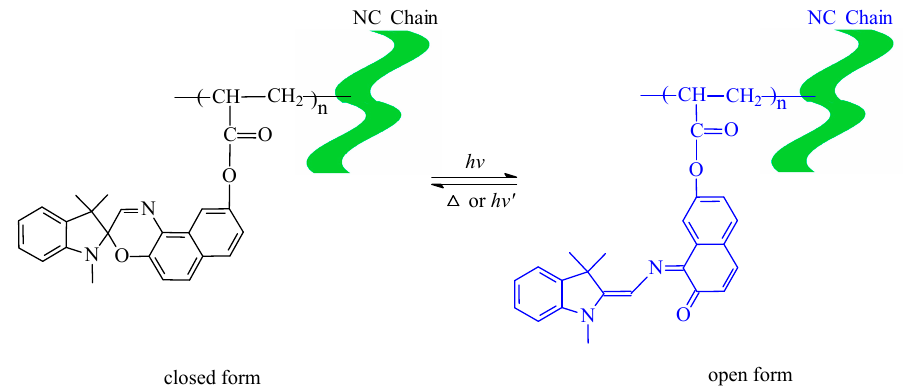
Figure 8. Photochromism of NC-g-AISO.